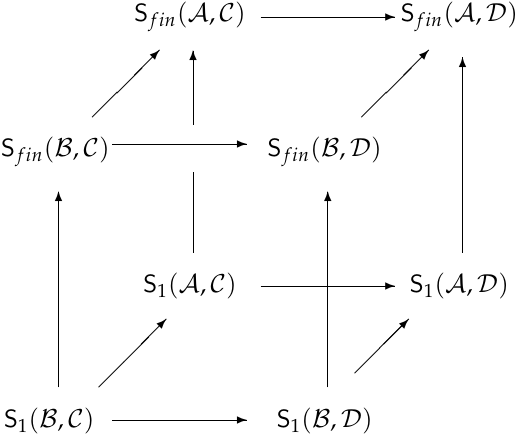
and A ⊂ B C ⊂ D and . A ⊂ B C ⊂ D